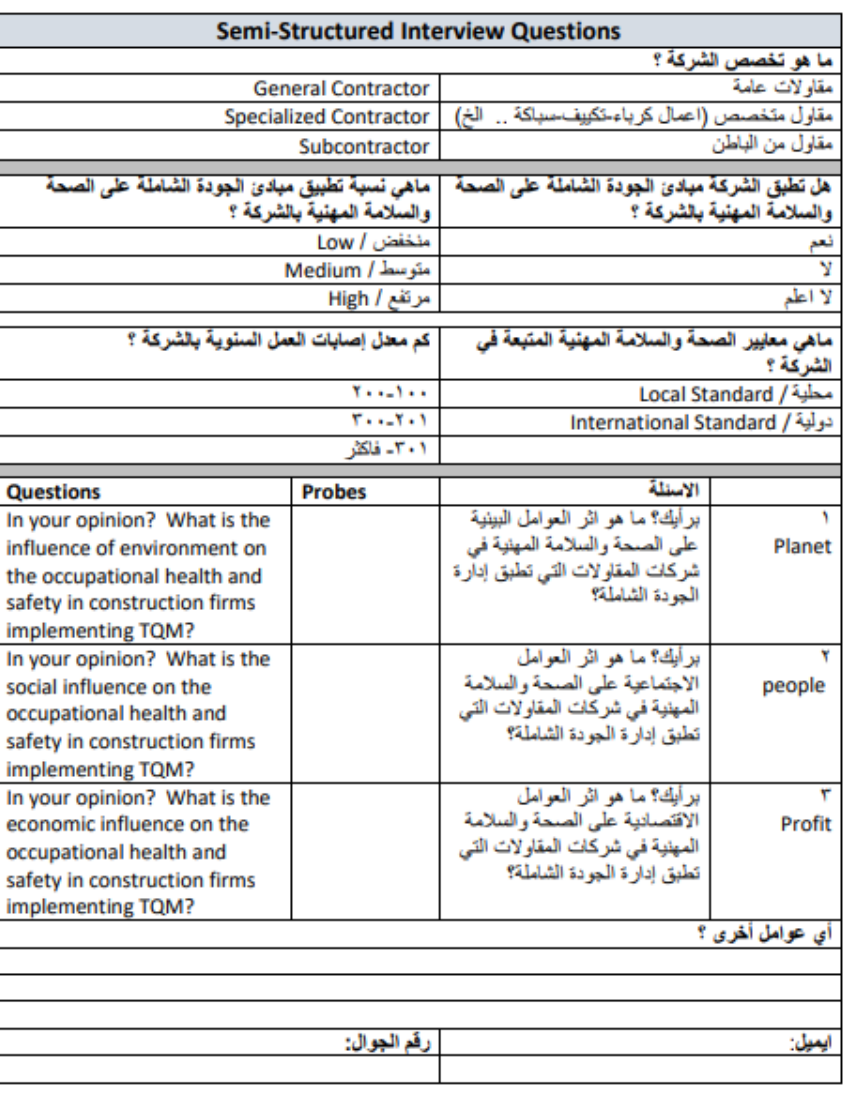
Figure A1. SSI questions including Arabic Language for non-English speaking participants, own study.